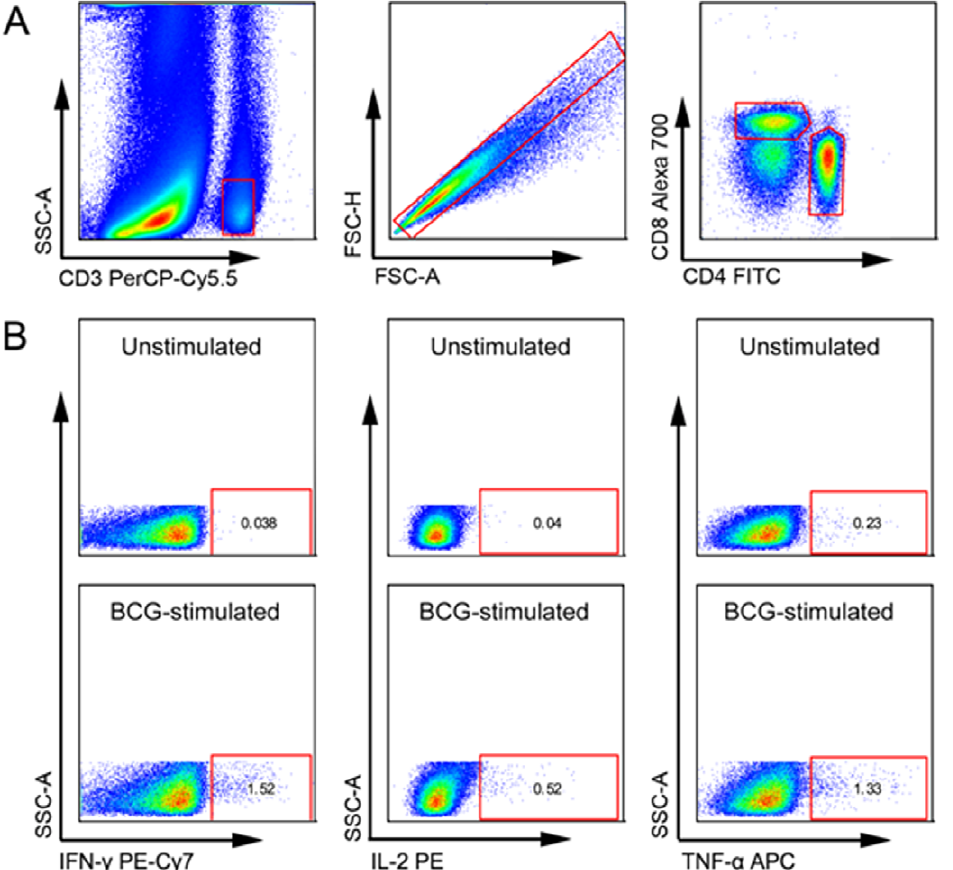
Figure 1. Gating strategy. (A) Selection of populations containing single cell CD4 or CD8 T cells. Each subsequent panel shows only the population of interest that has been selected from the gate on the previous plot. (B) Selection of CD4 T cells producing the cytokines of interest shown in an unstimulated and a BCG stimulated sample from one individual. The same gating strategy was used for CD8 T cells (not shown). Boolean gating was used to calculate proportions of polyfunctional T